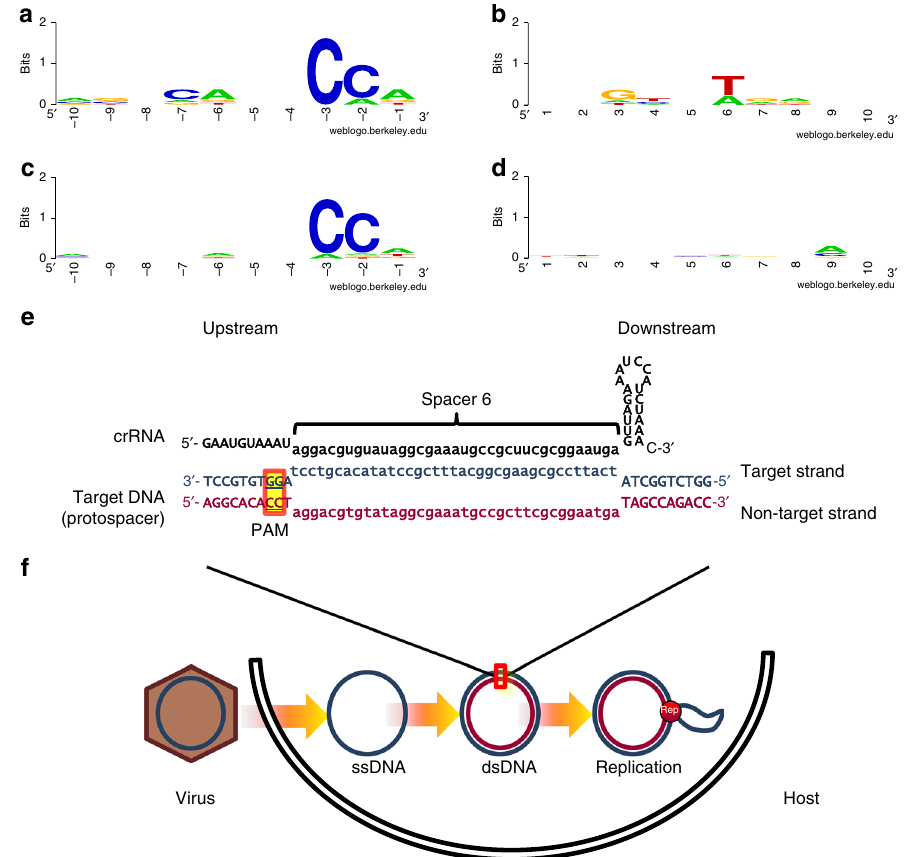
Fig. 2 Sequence conservation in fl anking regions of smacoviral Candidatus M. intestinalis Clustered Interspaced Short Palindromic Repeats (CRISPR) targets. Sequence logos represent conservation of 10 bases, in non-target strand, upstream (5' end of corresponding spacer in CRISPR RNA (crRNA)) ( a , c ) and downstream ( b , d ) from sequences targeted by the spacer in Ca . M. intestinalis. Up ( a , b ), conservation around the six matches identical to spacers. Down ( c , d ), conservation in best matches to each 23 spacers. e Representation of an R-loop, where crRNA from spacer 6 hybridizes to target double- stranded DNA (dsDNA) protospacer in smacoviurs. f Part of life cycle of a Circular Rep Encoding Single-Stranded DNA (CRESS-DNA) virus showcasing presence of dsDNA, targeted presumably by the Type I CRISPR-Cas system, after synthesis of complementary strand, and in replication. In e , f the viral strand is represented in blue, complimentary in garnet and RNA in